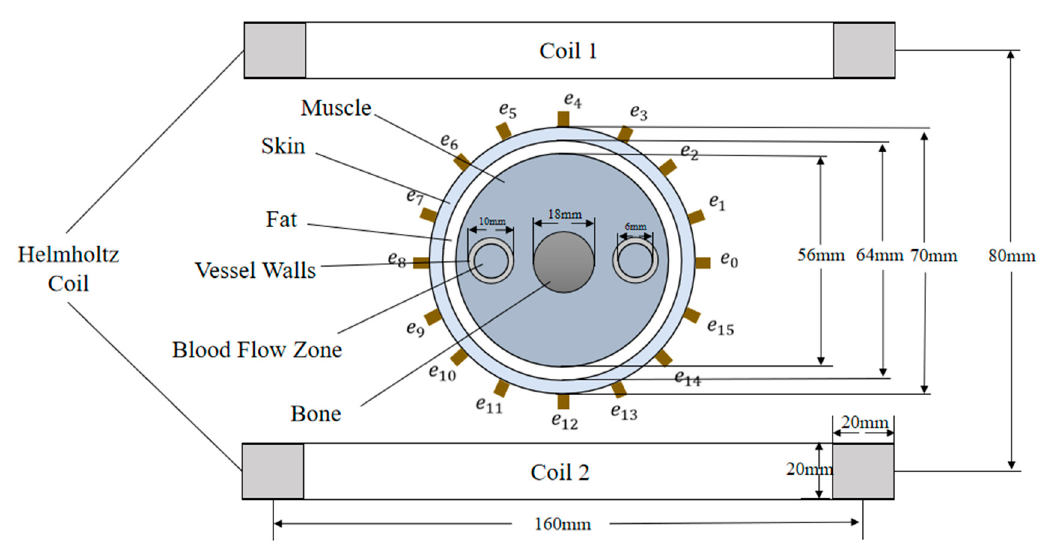
Figure 3. The basic structure of electromagnetic sensor used to predict arterial stenosis rate.